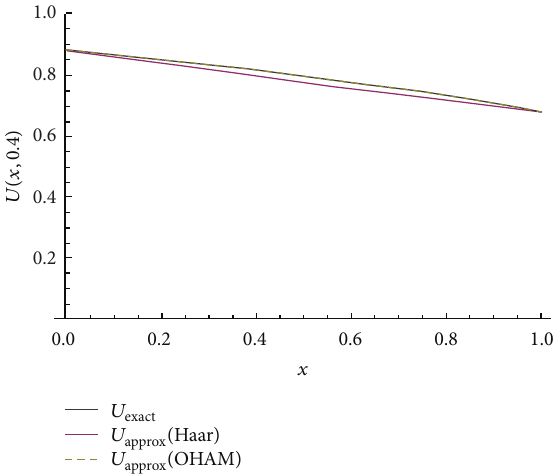
Figure 3: Comparison of Haar wavelet solutions and OHAM solutions with the exact solution of generalized Fisher’s equation when 𝑡 = 0.2 .